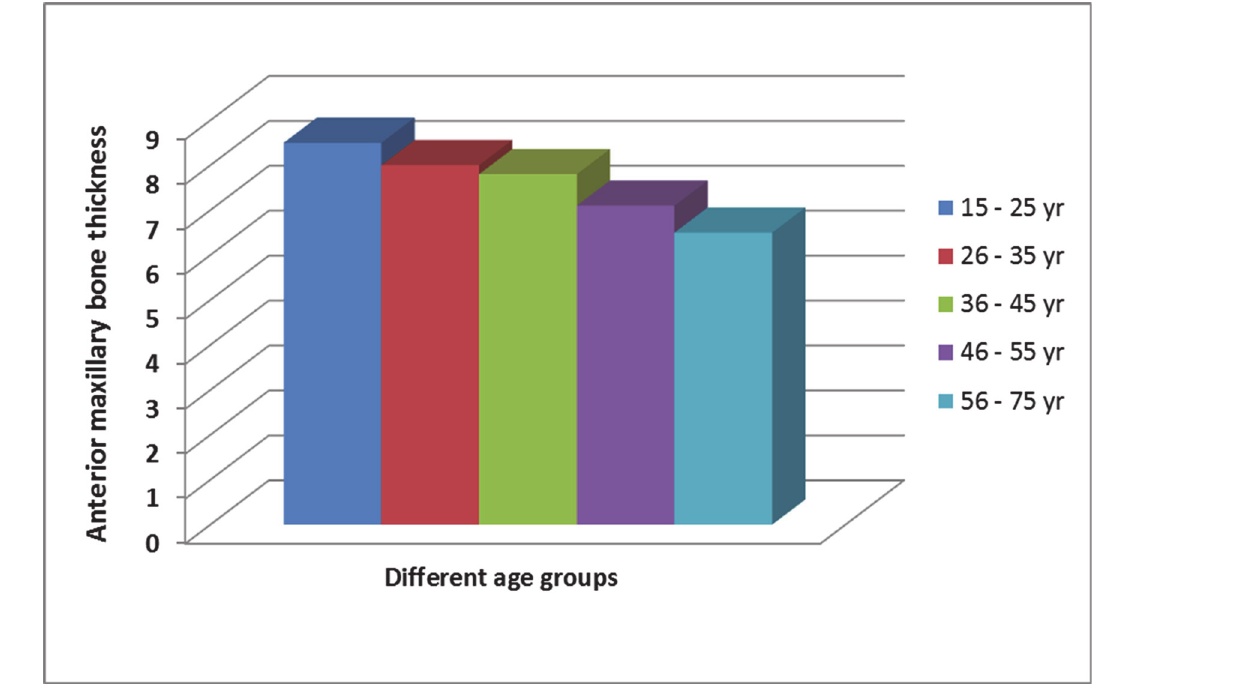
Fig 8. The reduction in anterior maxillary bone thickness with an increase of age.